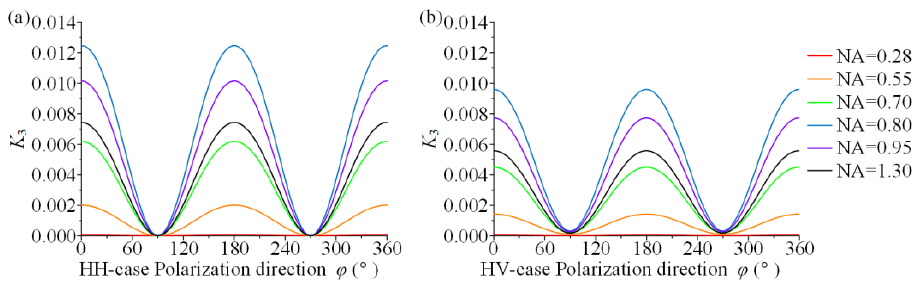
Figure 7. Ratio of the coefficient of the principal stress difference to that of the principal stress sum for different NA ( K 3 ): ( a ) HH-case; ( b ) HV-case.